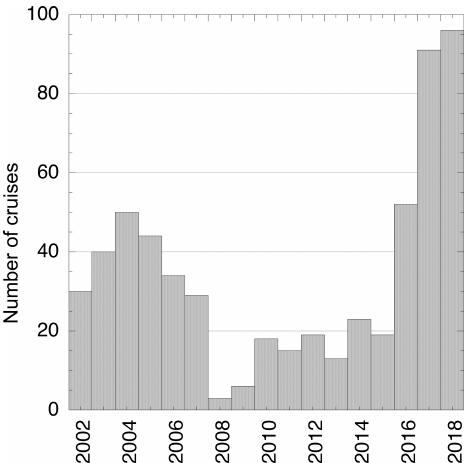
Figure 2. Histogram of number of cruises per year used in this